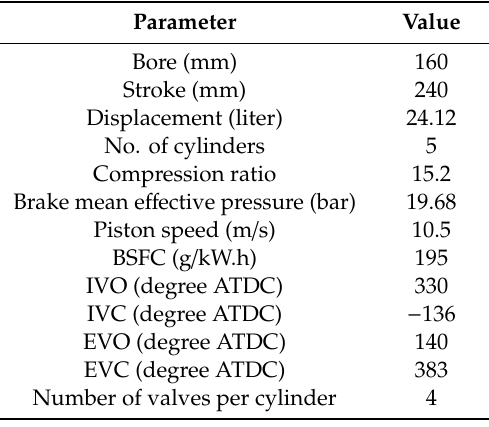
Table 1. Main specifications of MAN 5L16/24.